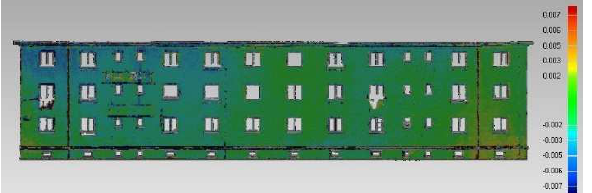
Figure 6. Pentax